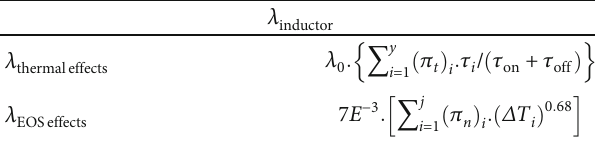
Table 3: Adjustment failure rates for the inductor.